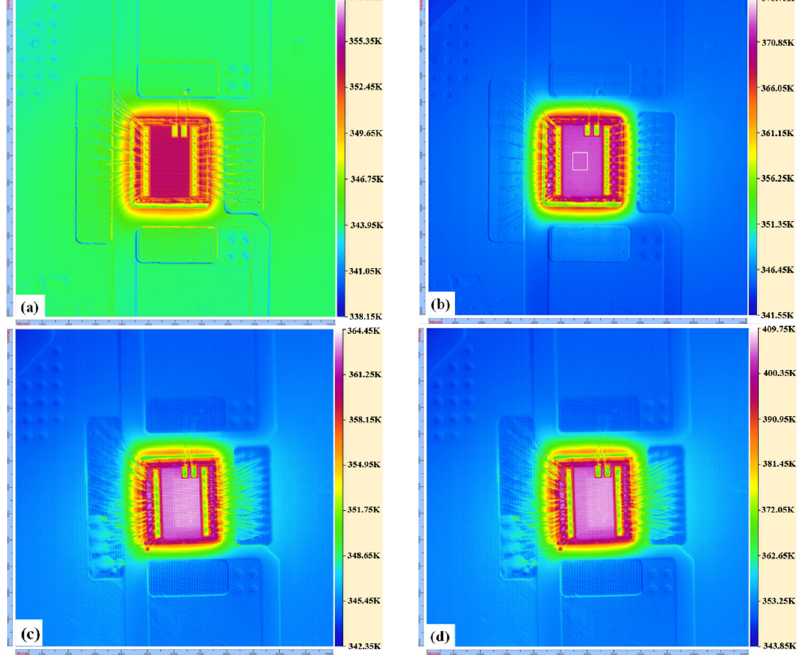
8 of 10 Table 2. Comparisons: measured result and calculated result of surface temperature. Test Devices